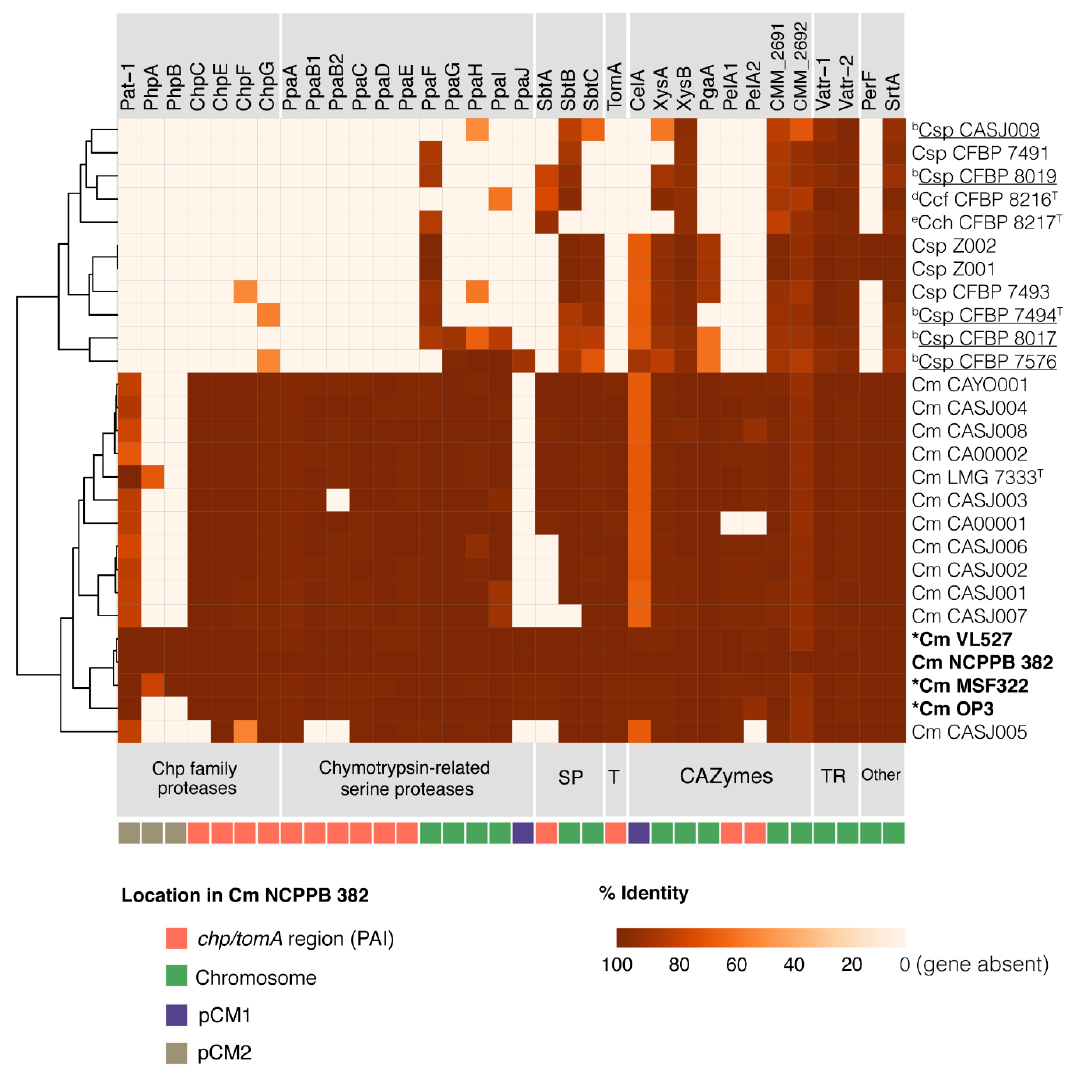
Figure 5. Heatmap of genes associated with virulence in C. michiganensis subsp. michiganensis pathogenic and non-pathogenic strains. Chp family proteases, chymotrypsin-related proteases, subtilase proteases (SP), tomatinase (T), carbohydrate active enzymes (CAZymes), transcriptional regulators (TR), and other virulence-related genes (Other) are shown in C. michiganensis subsp. michiganensis and endophytic strains (underlined). Heatmap shows identity (%) related to the corresponding amino acid sequences of strain NCPPB 382. Gene locations in the strain NCPPB 382 genome (PAI, chromosome, pCM1, pCM2) are indicated. Identity percentages are indicated in Table S6.